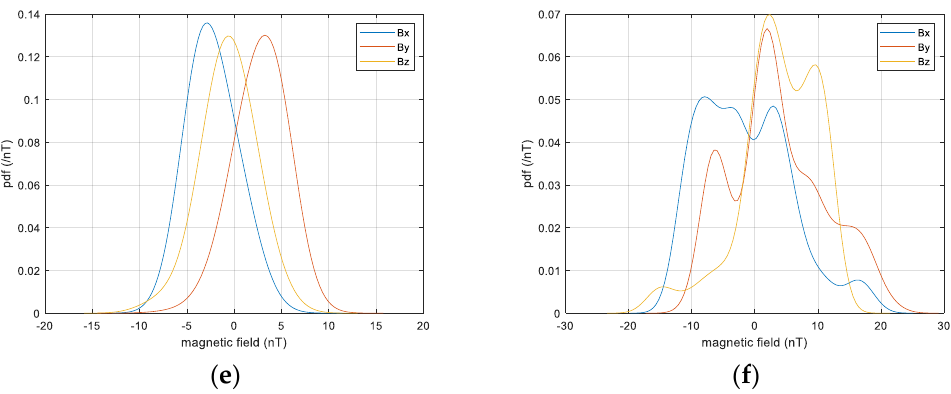
Figure 2. Probability densities of the magnitude of each component of the magnetic field. ( a ) 0:00 on